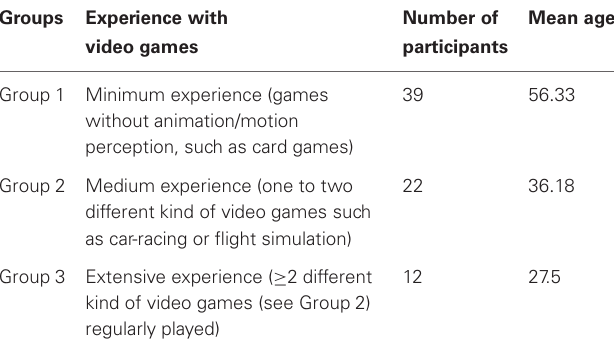
Table 1 | Grouping criteria for video game